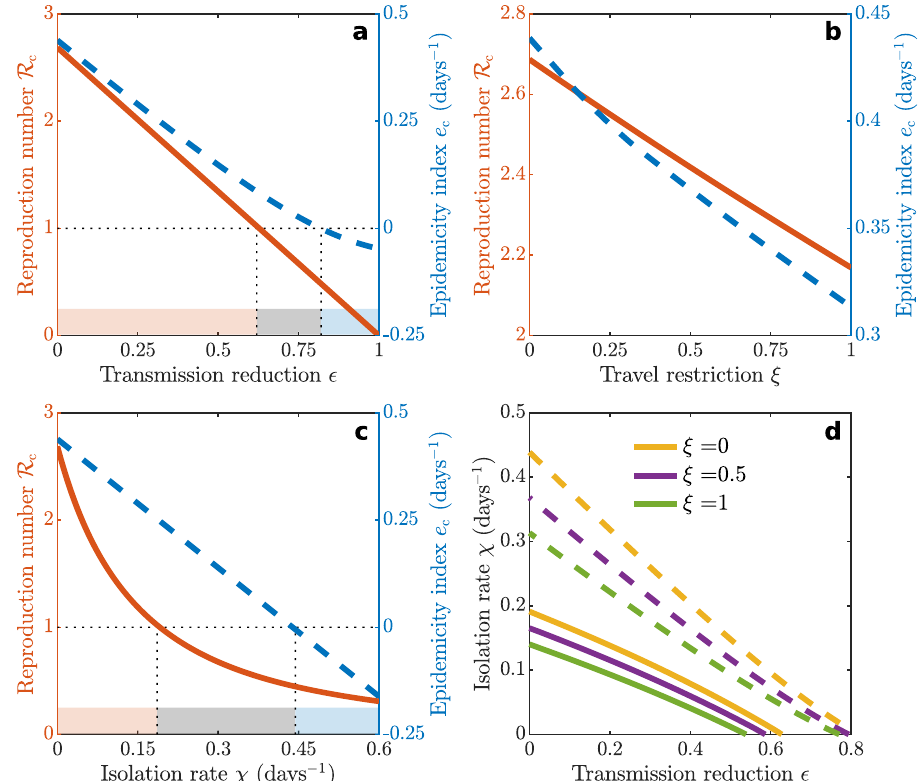
Fig. 3 The effects of spatially homogeneous control measures on long-term endemicity and short-term epidemicity of COVID-19 in Italy. a Plot of the relation between R c (left axis, red), e c (right axis, blue), and the spatially uniform transmission rate reduction ( ϵ i = ϵ for all i ’ s). b Same as ( a ) for the effects of travel restrictions ( ξ ij = ξ for all i ’ s and j ’ s). c Same as ( a ) for the effects of the isolation of infected individuals ( χ X i ¼ χ for all i ’ s and X ∈ { E , P , I , A }). d Simultaneous deployment of controls leading to R c ¼ 1 (solid curves) or e c = 0 (dashed) for three values of ξ , the imposed travel restriction. The DFE is asymptotically unstable ( R c > 1) for parameter values below the solid curves and endowed with negative epidemicity ( e c < 0) above the dashed curves. In all panels, w X = 1 ( X ∈ { E , P , I , A }, see “ Methods ” ). Colors at the bottom of a , c specify the ranges of endemicity/epidemicity conditions (red: R c > 1; gray: